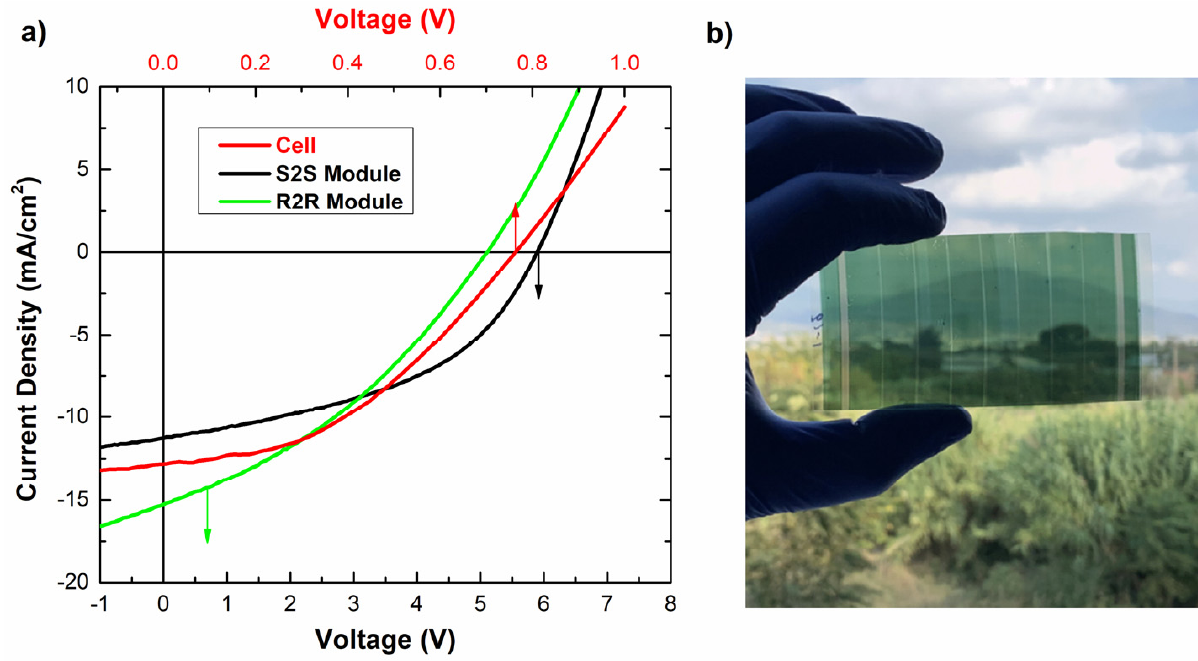
Figure 7. ( a ) Current density versus voltage for the fully printed semitransparent OPV cell and modules. ( b ) Photo of fully R2R printed OPV module with P1, P2 and P3 laser scribing processes achieving up to 91% Geometric Fill Factor. Table 3. Electrical characteristics of the OPV devices and modules.